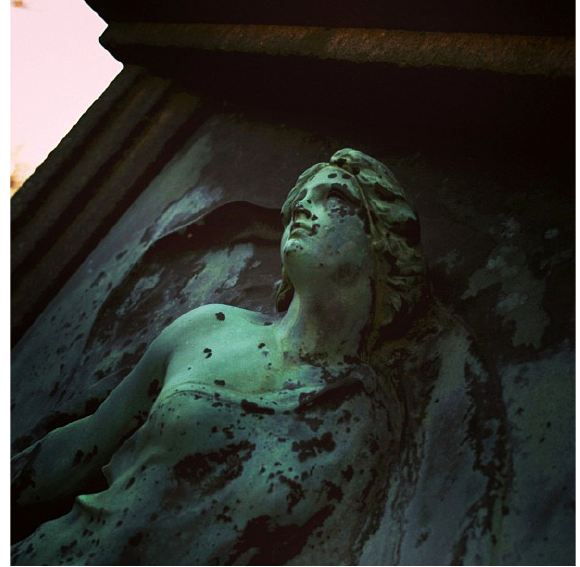
Figure 3. The photographer explored temporality of the